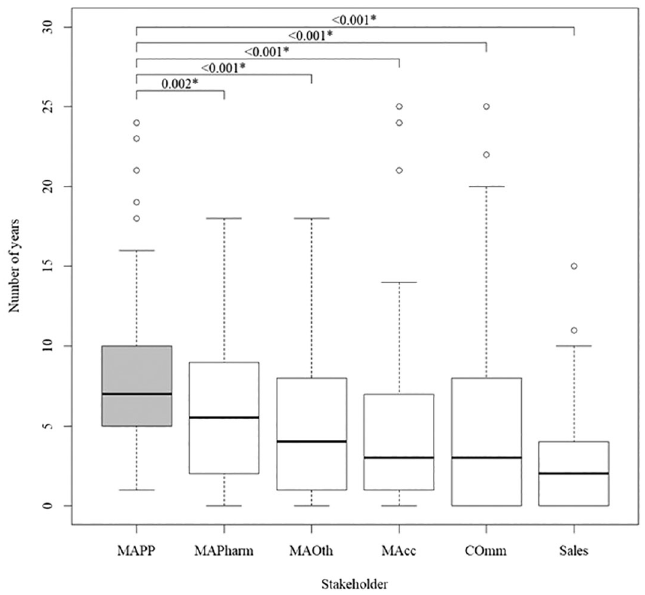
Figure 3. Number of years after completion of first degree for internal stakeholders to gain entry into the pharmaceutical industry, with MAPPs as the reference